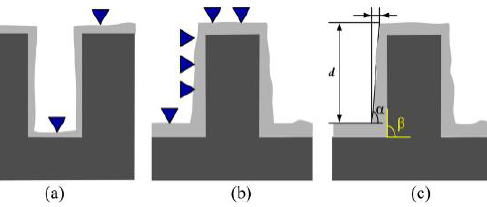
Figure 1. Description of the measurement of step coverage and conformality. ( a ) Step coverage, ( b ) conformality proposed by S. P. Krumdieck, and ( c ) conformality proposed in this